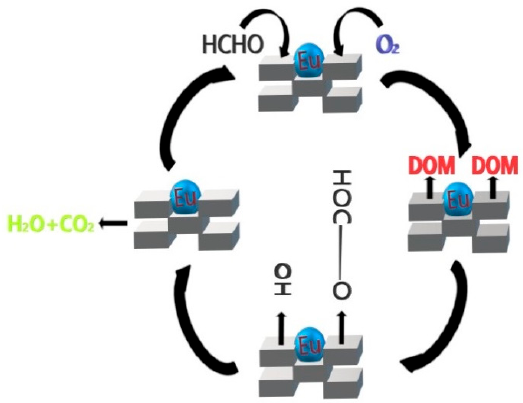
Figure 11. Proposed mechanism of HCHO oxidation over the Eu/NaSep sample.